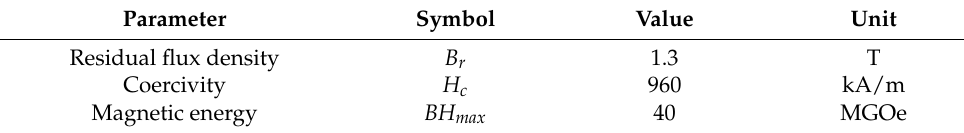
Table 2. Material parameters of the permanent magnet bearing.